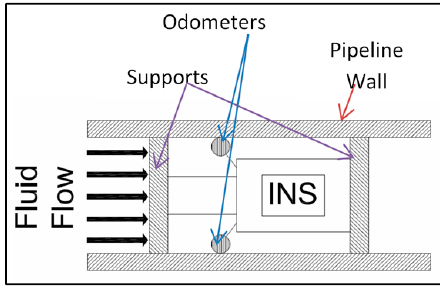
Figure 2. Main pig tool components.